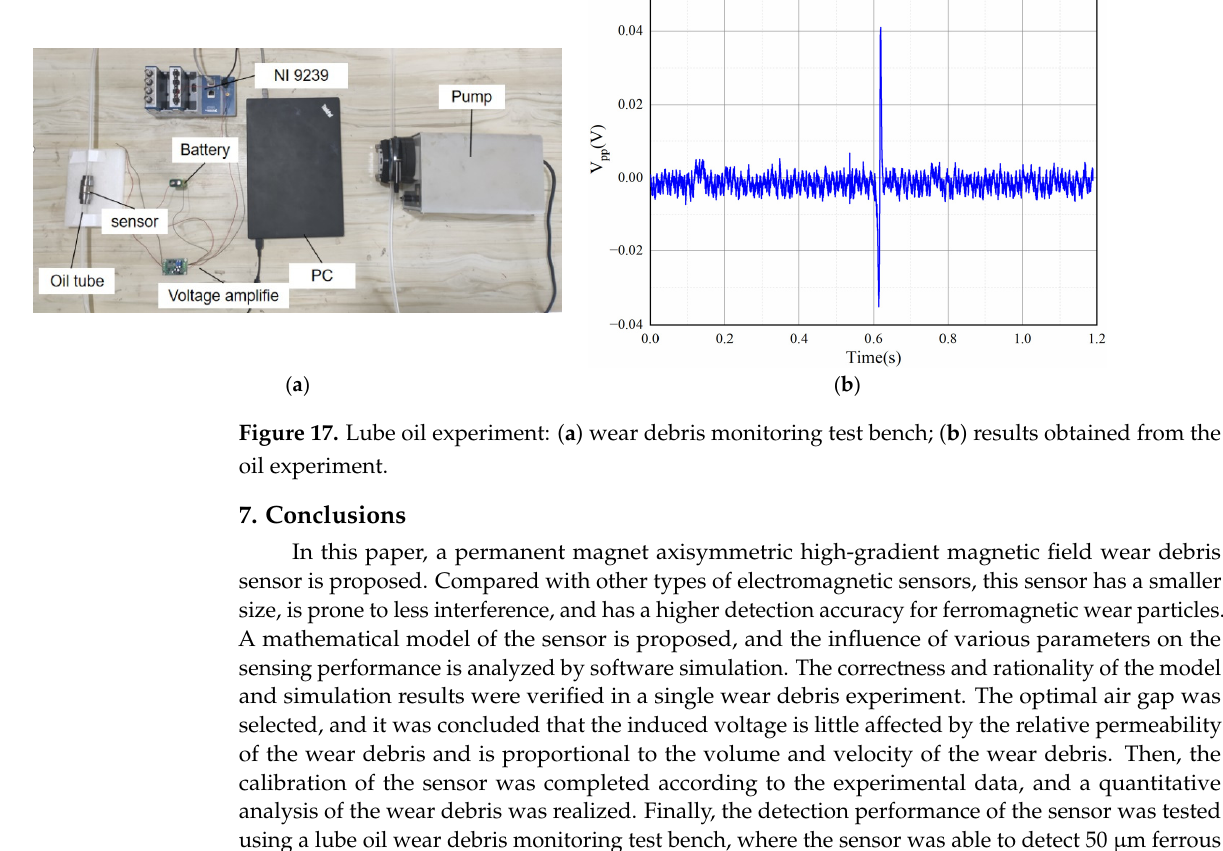
13 of 15 Figure 16. Comparison of experimental value and theoretical value. 6. Detection Accuracy of Ferromagnetic Particle To verify the actual detection effect of the sensor, a wear debris monitoring experi-